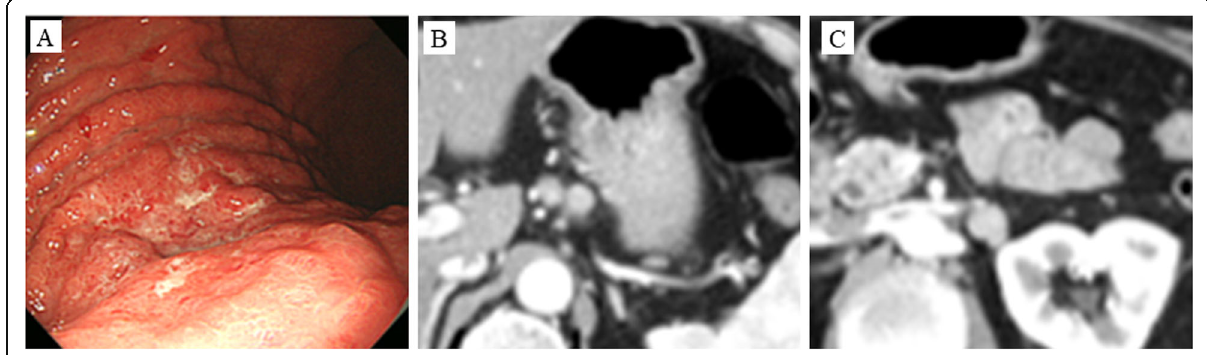
Fig. 1 Esophagogastroduodenoscopy (EGD) findings and computed tomography (CT) findings before chemotherapy. a EGD before chemotherapy revealed Borrmann type 4 cancer at the greater curvature from the upper to middle part of the gastric corpus. Abdominal CT before chemotherapy showed swollen regional lymph nodes ( b ) and para-aortic lymph nodes ( c